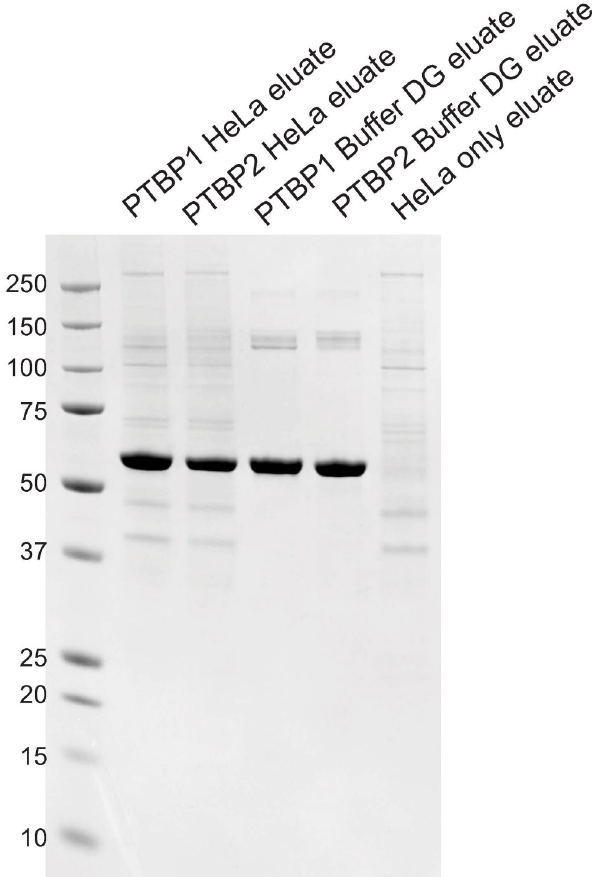
Fig 2. Purification of His- 6 tagged PTBP from splicing reaction mixtures. Splicing reaction mixtures contained 2.2mM MgCl 2 , 0.4mM ATP and 20mM Creatine Phosphate and either HeLa nuclear extract or Buffer DG. Aliquots (10 μ l) of the indicated fractions were analyzed by SDS-PAGE. The gel was stained with Gel Code blue safe stain. The positions and sizes (kilodaltons) of marker polypeptides are shown on the